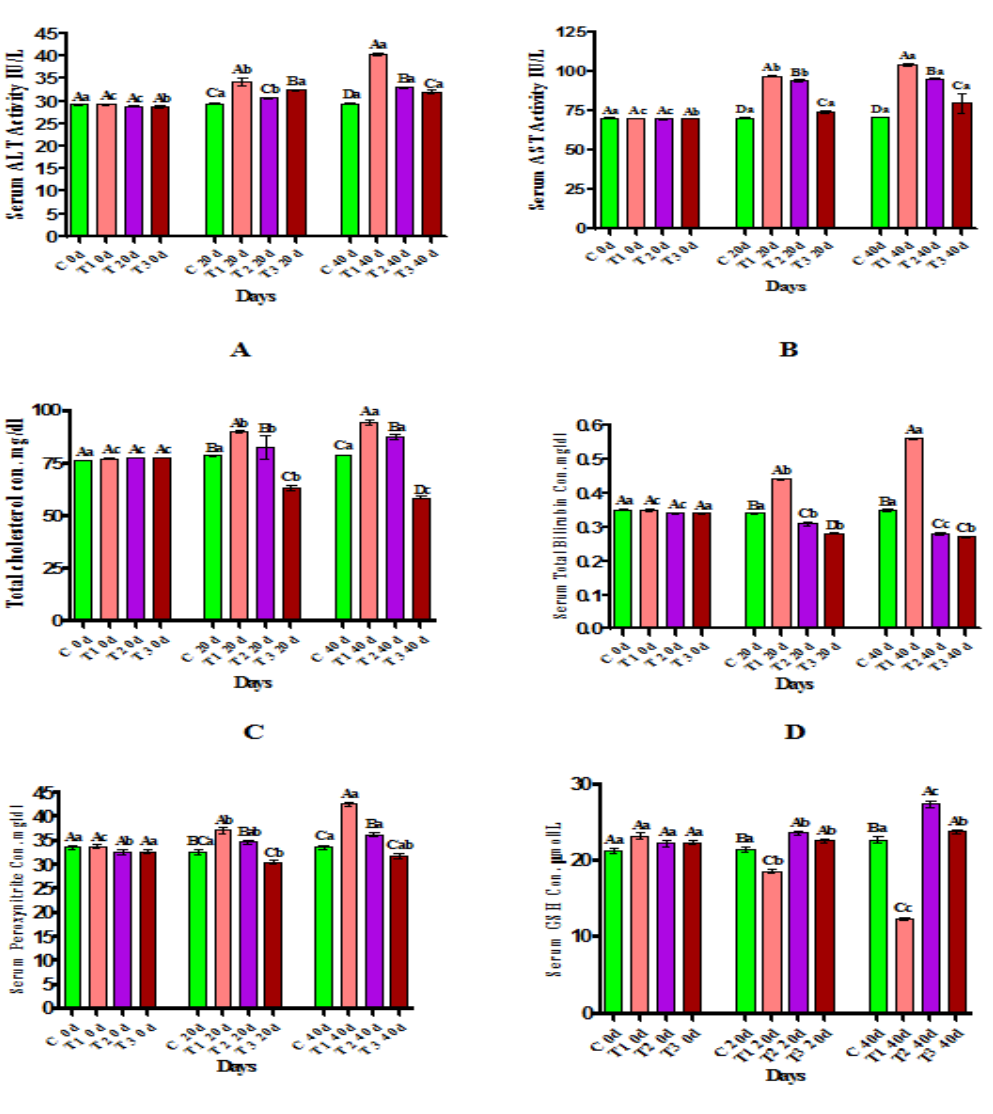
Figure (2): Effect of pomegranate seed oil (PSO) on serum biochemical tests in female rats treated with sodium fluoride.